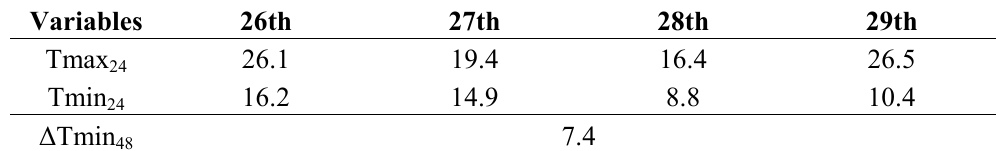
Notes: Tmax denotes daily maximum temperature; Tmin24 denotes daily minimum 24 temperature, and Δ Tmin denotes minimum temperature difference in 48 h. 48